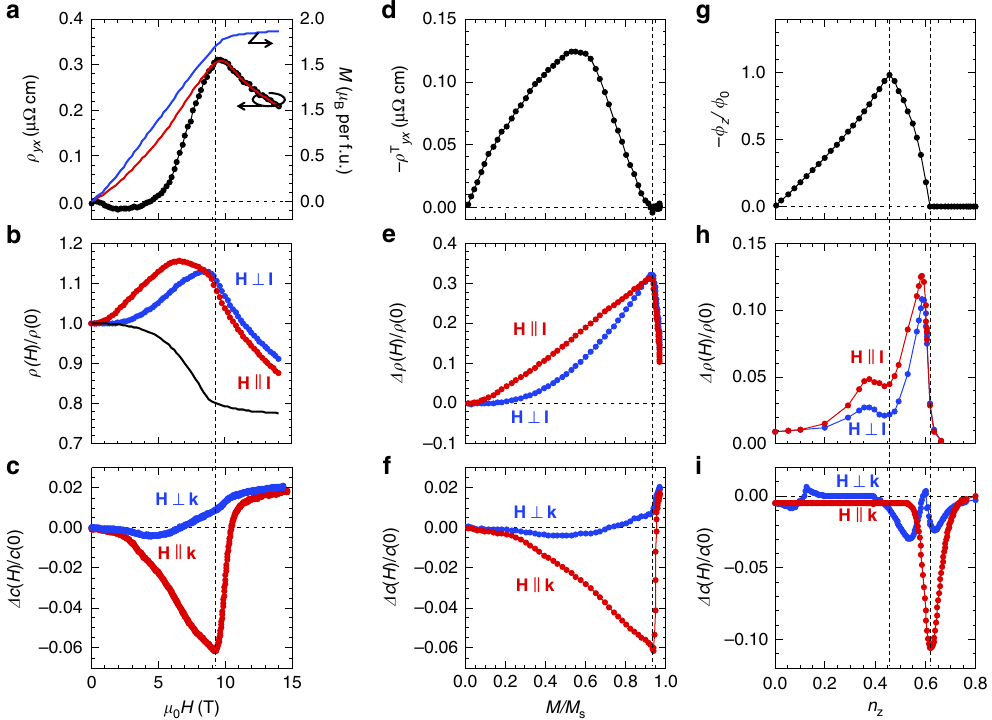
Figure 2 | Experimental and theoretical results on unusual magneto-transport and elastic properties originating from emergent monopoles. ( a – c ) Experimental results on magnetic-field dependences of magnetization (blue line), expected usual Hall resistivity (red line) due to normal and anomalous Hall effects and observed Hall resistivity (dots) ( a ); expected usual MR (black line) and observed longitudinal and transverse MRs ( b ) change in elastic constants with propagation directions parallel and perpendicular to the magnetic field ( c ) at 30K. Experimental estimates of topological Hall resistivity ( d ) positive contributions to MRs ( e ), which deviate from the usual MR profile (black curve in b ), and relative elastic constants ( f ) at 30K as functions of normalized magnetization M / M s , M s being the low-temperature and high-field (for example, 2K and 14T) saturated value of M . ( g – i ) Theoretical calculations on static emergent magnetic flux (cid:6) f z in a unit of f 0 ¼ h / e ( g ) longitudinal and transverse MRs originating from emergent field ( h ) elastic constants ( i ) as functions of the polarization factor n z Comparison with theoretical predictions . The above experi- mental results are consistent with theoretical predictions of unique features associated with the monopole dynamics in MnGe.